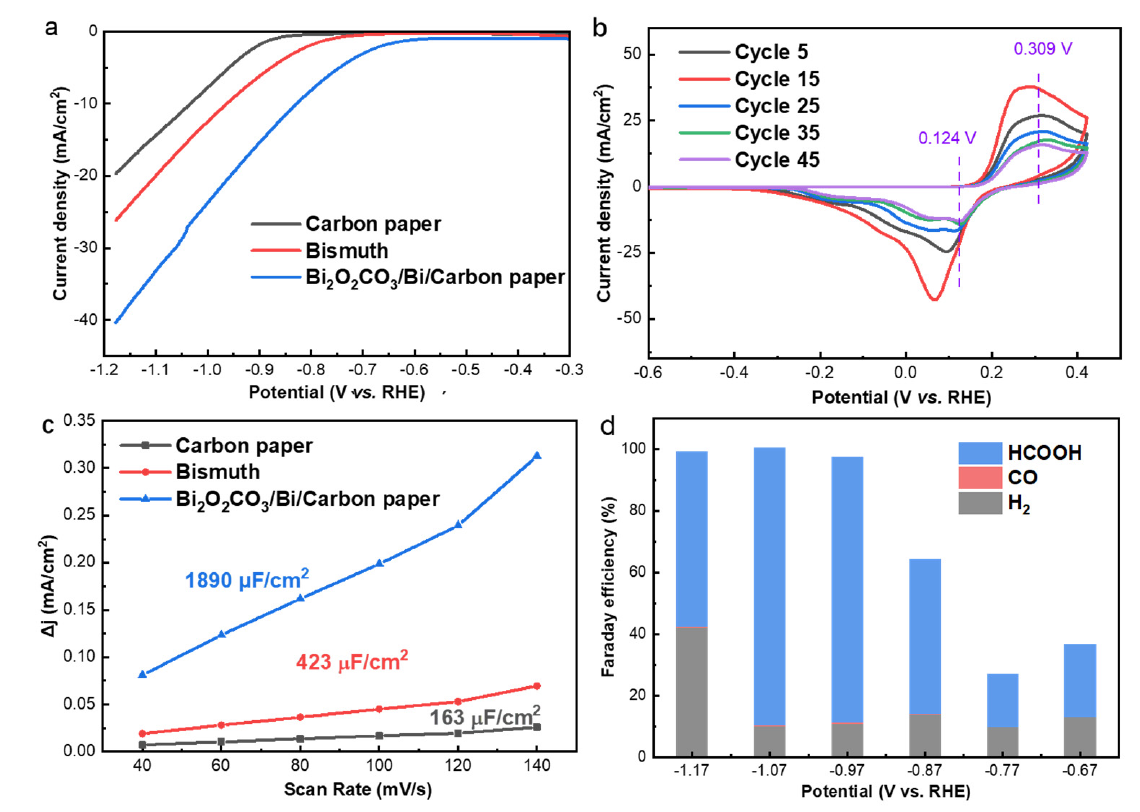
Figure 4. ( a ) LSV curves of Carbon paper, Bi electrodeposited at 1.6 mA (0.8 mA cm − 2 ) and Bi 2 O 2 CO 3 @Bi/CP; ( b ) CV curves of Bi 2 O 2 CO 3 @Bi/CP in CO 2 -saturated 0.50 M KHCO 3 electrolyte; ( c ) Charging current density differences plotted against scan rates; ( d ) FE of CO 2 RR products at various potentials on Bi 2 O 2 CO 3 @Bi/CP in CO 2 -saturated 0.50 M KHCO 3 electrolyte.